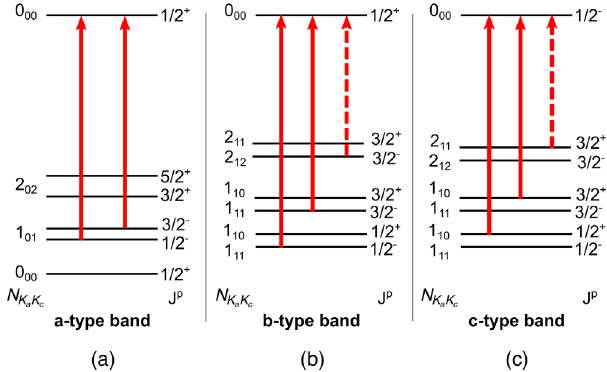
FIG. 6. Schemes to achieve rotationally closed photon cycling for pure (a) a -type transitions, (b) b -type transitions, and (c) c - type transitions. Dashed lines indicate transitions that will need to be repumped in special cases, as described in the text. In ¼ 1 levels, the spin-rotation and asymmetry doubling the K a are approximately the same size. These level diagrams assume a near-prolate ATM, but analogous results apply for near- oblate